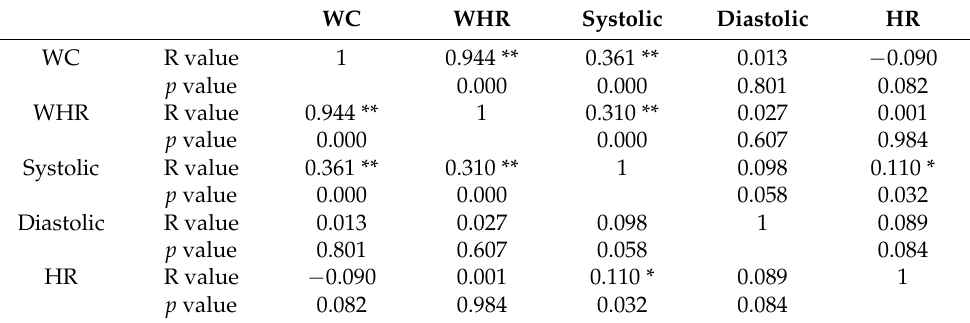
Table 2. Correlation coefficients of health risk factors